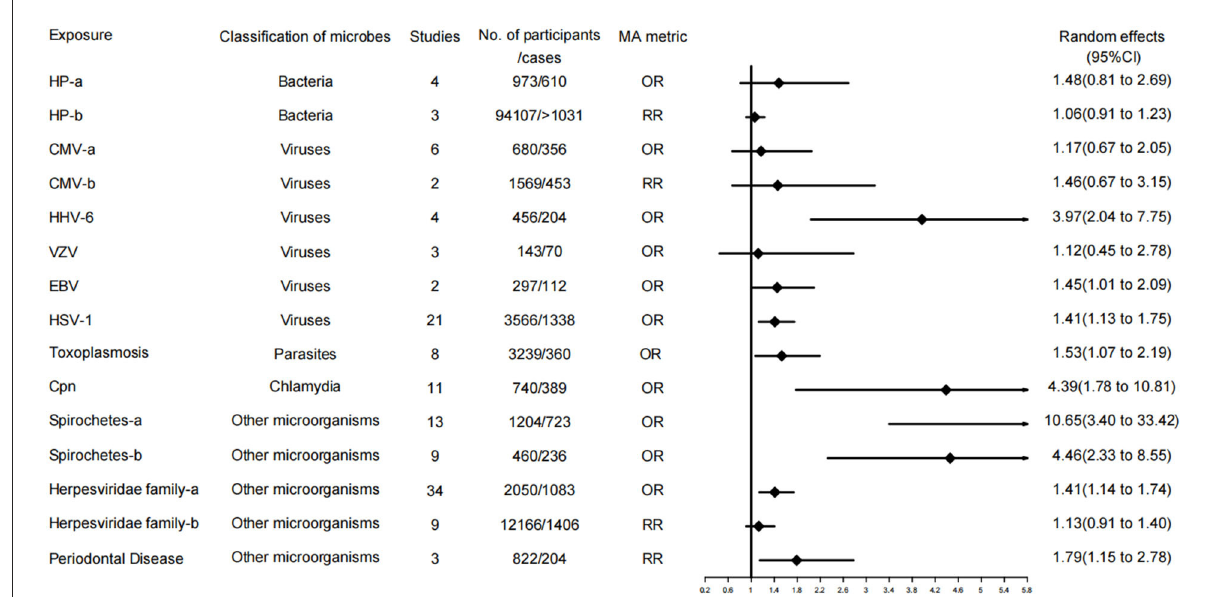
FIGURE3 Forest plots and the level of evidence of the association of microbiological factors with Alzheimer’s disease. Herpesviridae family-a, Herpesviridae family in case control studies; Herpesviridae family-b, Herpesviridae family in cohort and nested case control studies; CMV-a, CMV in case control studies; CMV-b, CMV in cohort and nested case control studies; HP-a, HP in case control studies; HP-b, HP in cohort studies; Spirochetes-a, all studies; Spirochetes-b, conservative studies; CMV, cytomegalovirus; HHV-6, Human herpes virus type 6; VZV, varicella zoster virus; EBV, Epstein Barr virus; HP, Helicobacter pylori; HSV-1, herpes simplex virus type 1; Cpn, Chlamydophila pneumoniae.